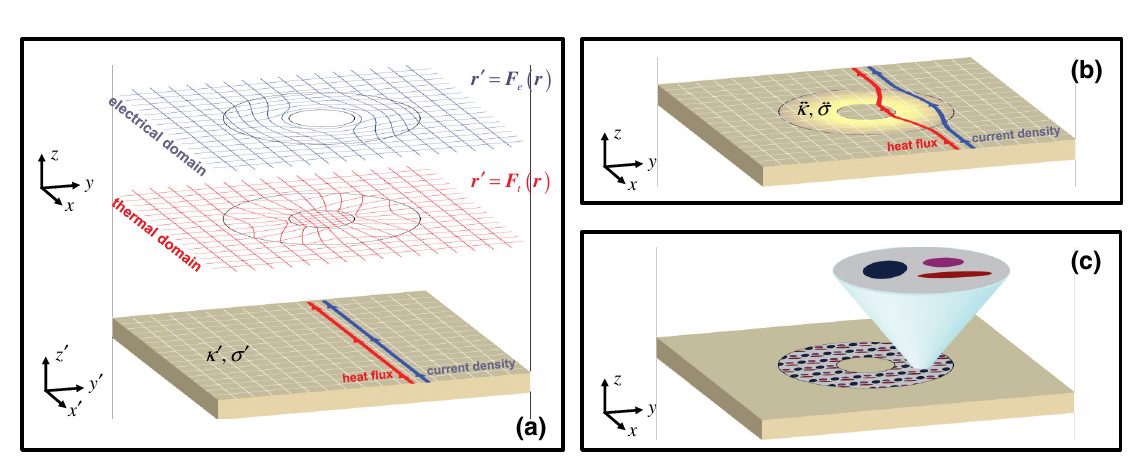
FIG. 1. (a) Auxiliary space filled with an isotropic, homogeneous medium, wherein heat flux and electrical current density follow parallel straight paths. Two coordinate transformations are applied that induce different behaviors in the thermal (e.g., concentrator) and electrical (e.g., cloak) domains. (b) Equivalent interpretation, in a flat-metric space filled with a transformation medium [cf. Eq. (4)]. The heat-flux and current-density paths are distorted in different fashions. (c) Metamaterial-based approximate implementation of the required nominal constitutive parameters via a mixture of inclusions of different shapes and materials (as qualitatively depicted in the magnified details) embedded in a host